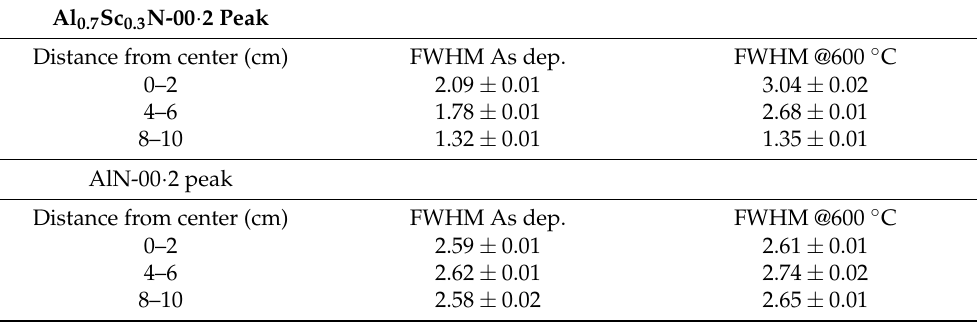
Table 4. FWHM values for the different RC